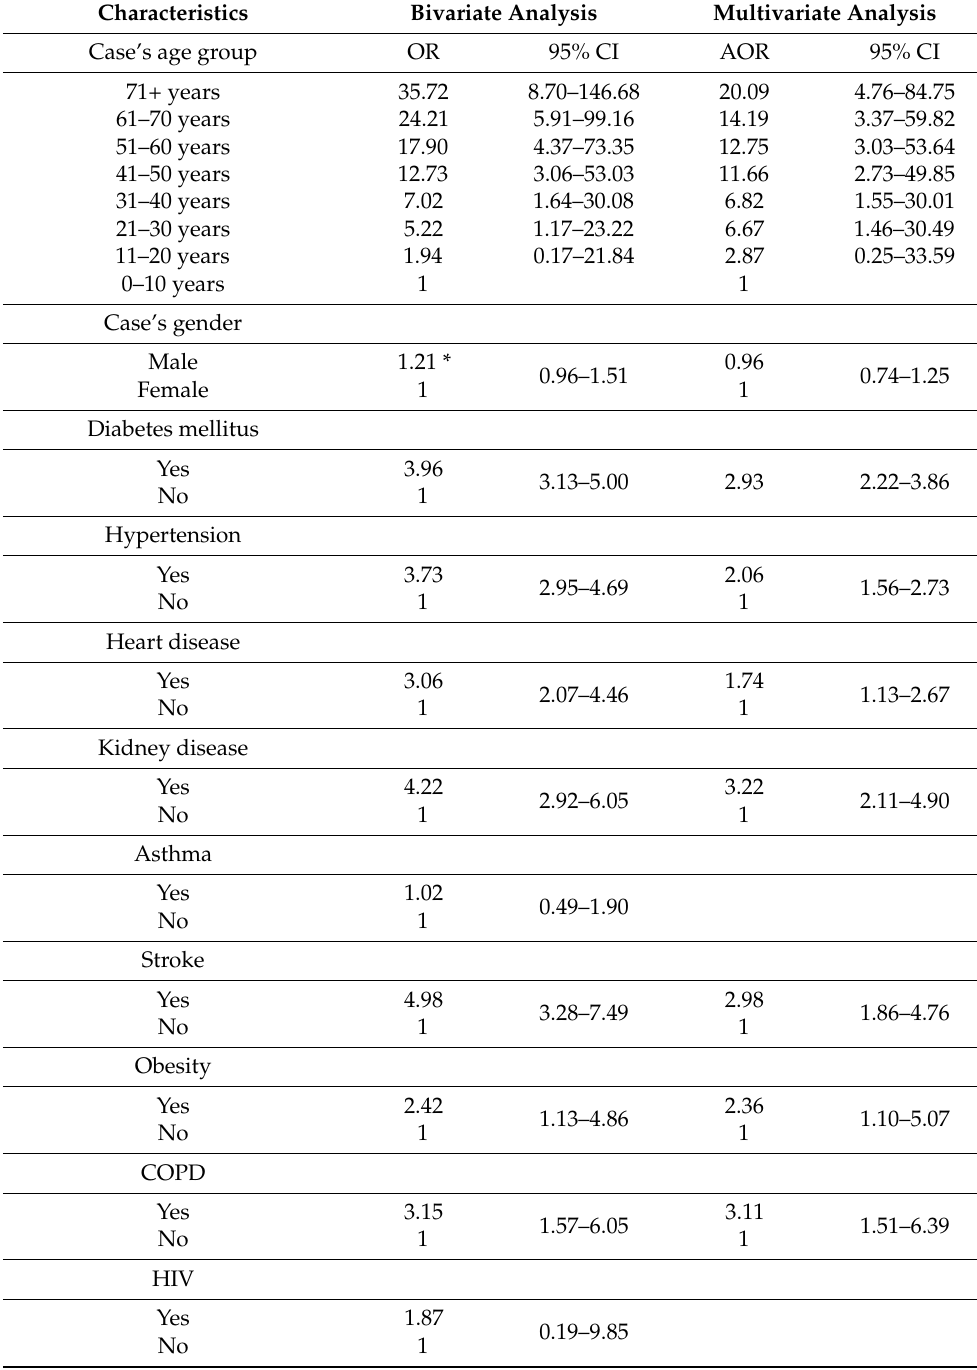
Table 2. Bivariate and multivariate analysis using simple and multiple logistic regression